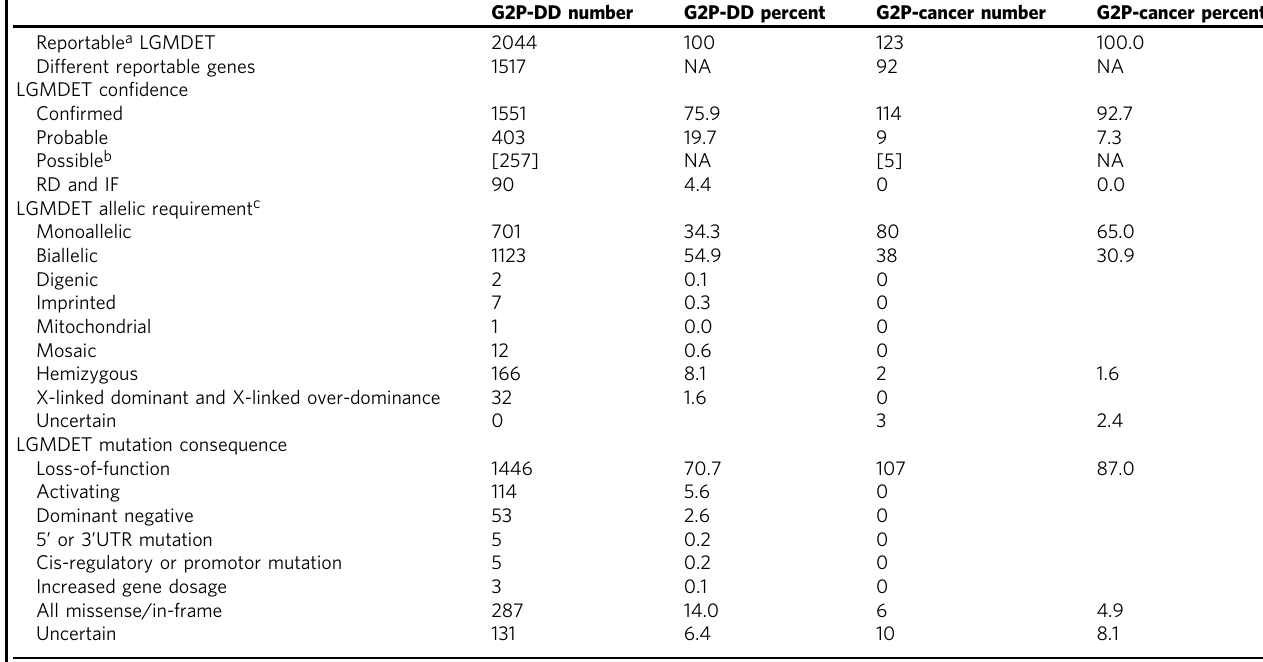
Table 1 January 2018 freeze of G2P